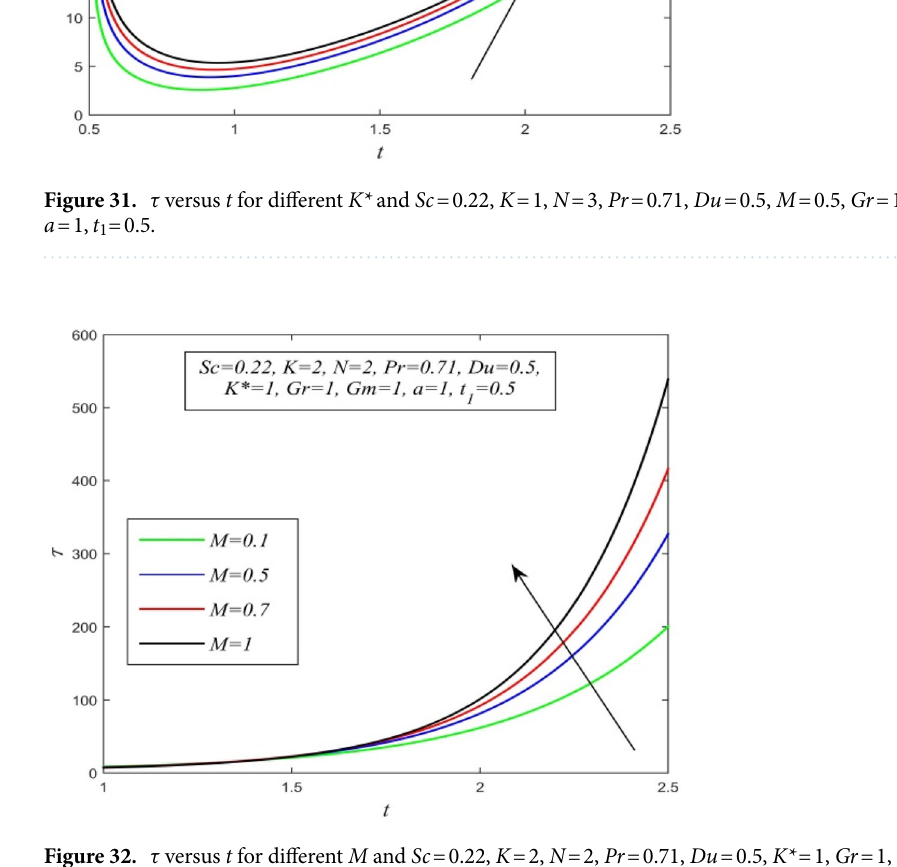
Figure 32. τ versus t for different M and Sc = 0.22, K = 2, N = 2, Pr = 0.71, Du = 0.5, K* = 1, Gr = 1, Gm = 1, a = 1, t 1 =